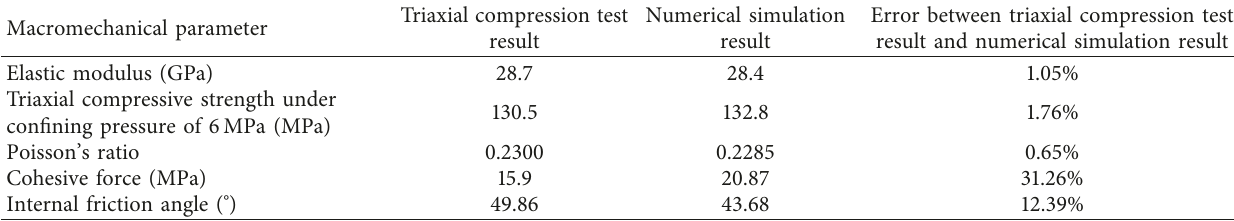
Table 1: Physicomechanical parameters and PFC results.